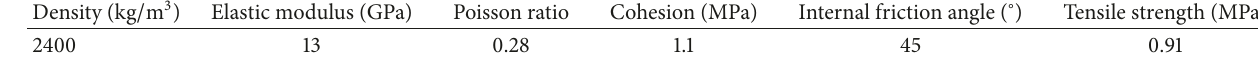
Table 1: Mechanical parameters for the rock.